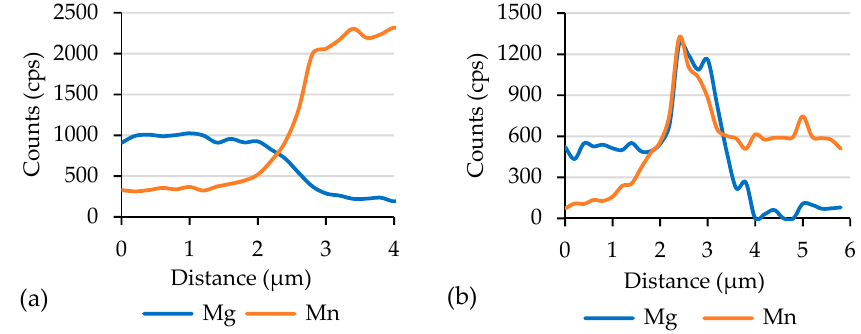
Figure 9 . EDS line scans shown in Figure 8c: ( a ) EDS line scan 1 and ( b ) EDS line scan 2.